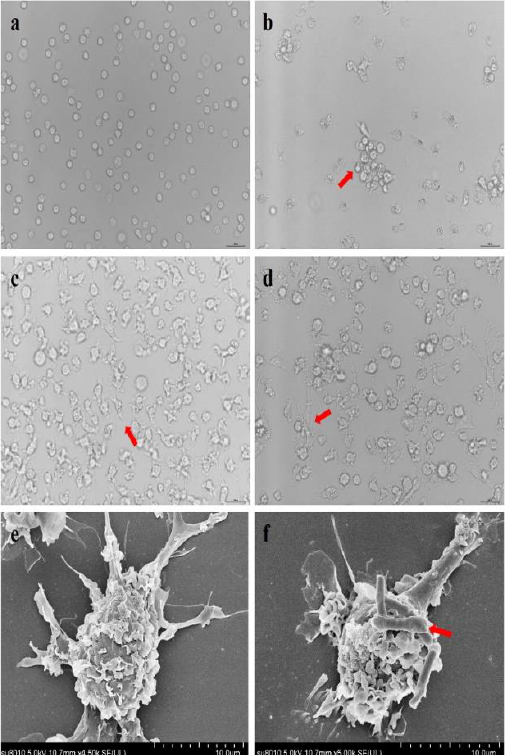
Figure 3. Porcine MoDCs formation at different cultured period and adhesion of L. johnsonii-COE to MoDCs. ( a – d ) The images were observed by light microscopy , and scale is 100 um ; ( a ) CD172a + monocytes; ( b ) monocytes on 2 days; ( c ) monocytes on 4 days; ( d ) MoDCs on 6 days; the red arrows in ( b – d ) present dendritic morphology. ( e ) MoDCs seen by SEM; ( f ) some L. johnsonii-COE adhere to MoDCs under SEM, the red arrows present L. johnsonii-COE